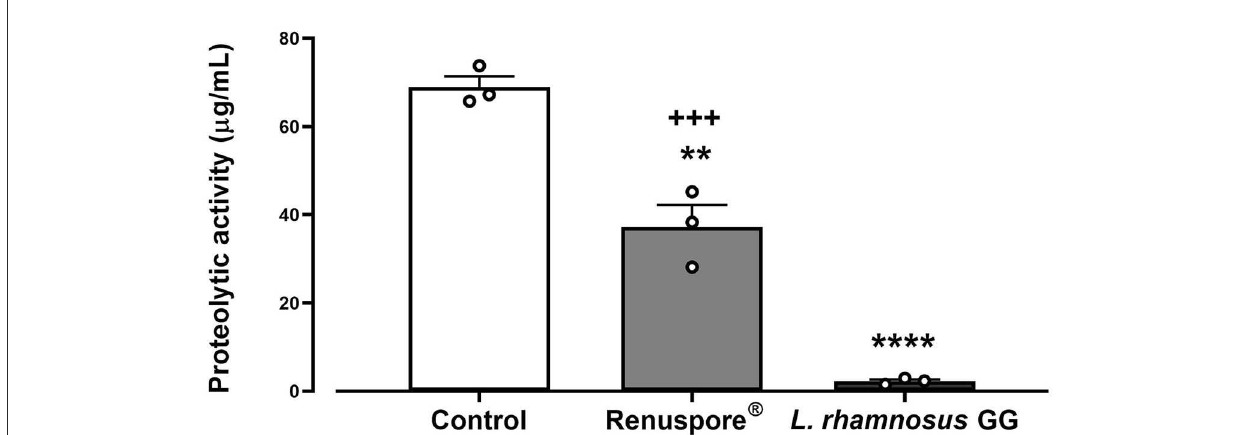
FIGURE7 Renuspore ® demonstrates superior protease activity ( µ g/mL) to L. rhamnosus GG. The results show average concentration ( n = 3) ± standard error. Significant difference observed between Renuspore ® and positive control (Proteinase K): ** p < 0.01. Significant difference observed between Renuspore ® and L. rhamnosus GG: +++ p < 0.001. The results were statistically analyzed using the one-way analysis of variance (ANOVA) (biological replicates n = 3) followed by Tukey’s multiple comparison test using GraphPad Prism v.9. Significant difference observed between L. rhamnosus GG and control (Pritenase K) is indicated: **** p < 0.0001.